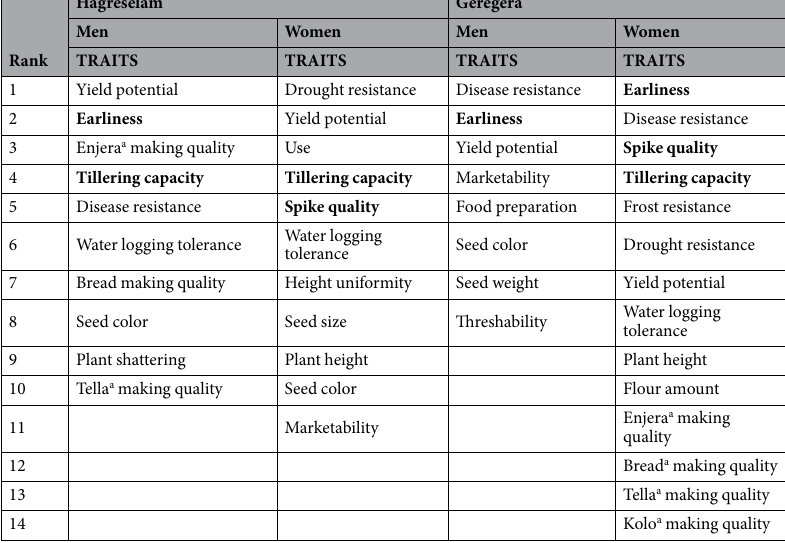
(Table 1). We found a general similarity in the field-related traits listed by men and women in each location. Conversely, derived traits such as suitability for drink and food preparations were perceived differently by gender. Marketability was important only for women in Hagreselam, but only for men in Geregera. The opposite occurred for local beer preparation ( tella ) (Table 1). Women in Hagreselam used a larger number of traits to evaluate wheat